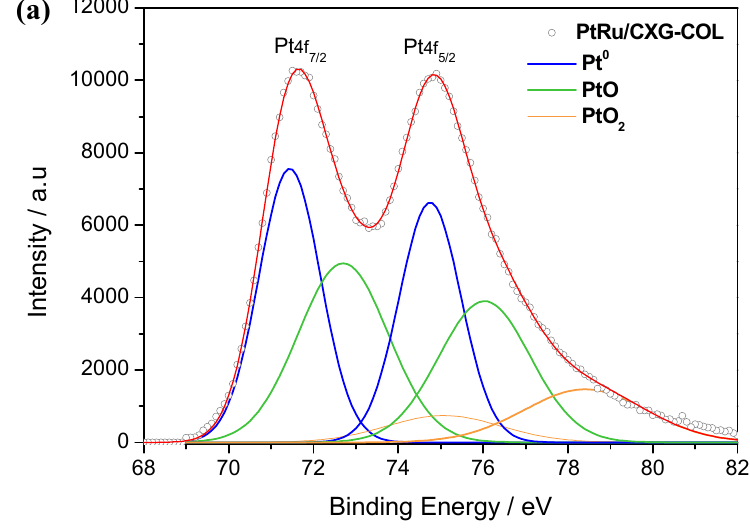
Figure 3. XPS signals for ( a ) Pt and ( b ) Ru for the catalyst